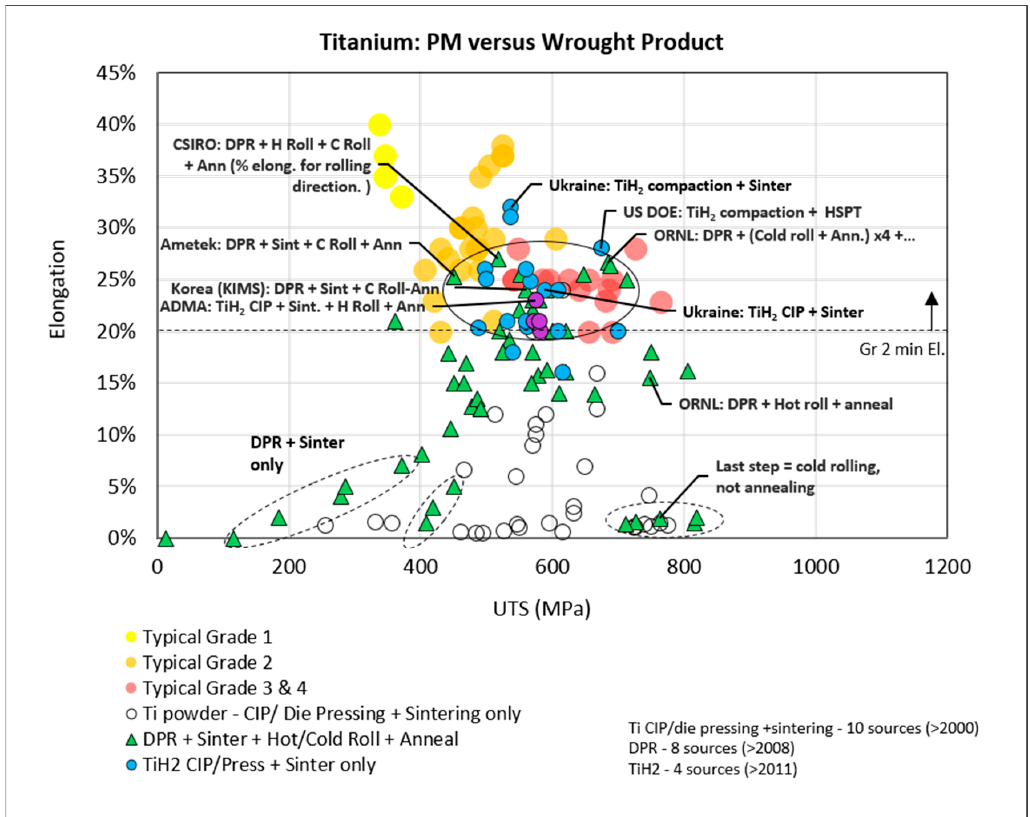
Figure 9. Elongation and ultimate tensile strength of wrought product versus PM compacts from various process routes and feedstock.